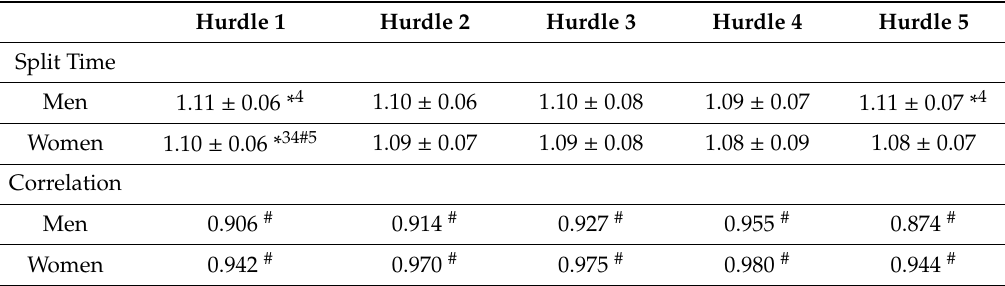
Table 1. Evolution of the hurdle-unit split times (s) and relationships (r) with the 60 m hurdle race results during the 44th Spanish Indoor and 12th IAAF World Indoor Championships. Hurdle 1 Hurdle 2 Hurdle 3 Hurdle 4 Hurdle